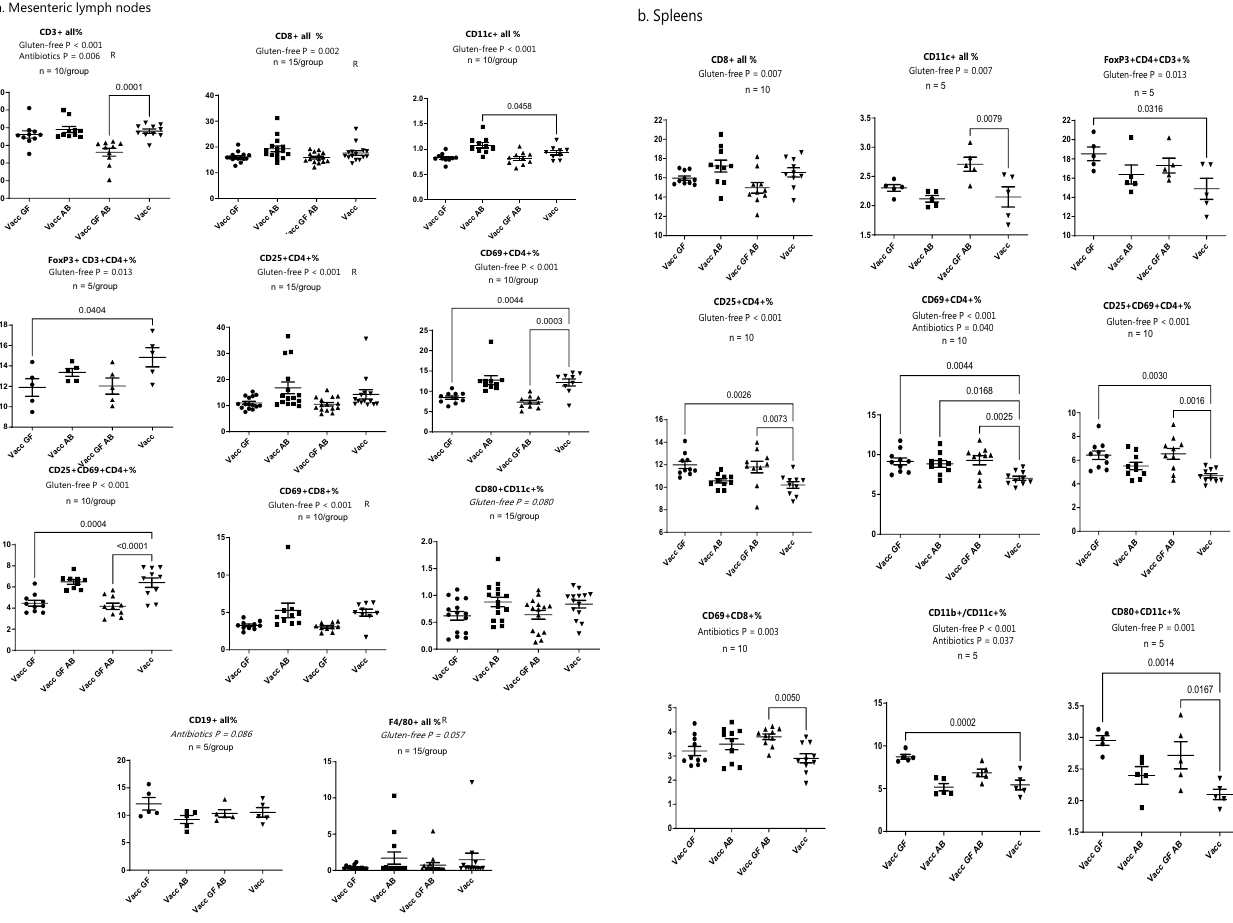
Fig 5. Effects of a gluten-free diet or antibiotics on immune cell counts as a response to a tetanus vaccine. Flow assisted cell sorting (FACS) data (See Table 1) from the mesenteric lymph nodes (A) and the spleens (B) of female BALB/cBomTac, which were either fed standard wheat based Altromin diet or a modified gluten-free Altromin diet (GF). Mice on both diets were either given ampicillin (AB) in the drinking water (Antibiotics; gluten-free + antibiotics) or given pure drinking water (Gluten-free; vaccinated control). All mice were vaccinated with a tetanus vaccine (Vacc) and one week later MLN were sampled. Only data being significantly different between the groups are shown. R indicates that data have been ranked before statistical tests due to the lack of equal variances and/or normal distribution. Over all p-values are the outcome of two-way ANOVA for the two factors ‘gluten-free’ and ‘antibiotics’, while the values on the comparison lines are the p-values for the post-hoc Dunnett’s test comparing the Vacc GF, Vacc AB and the Vacc GF AB with the Vacc group.